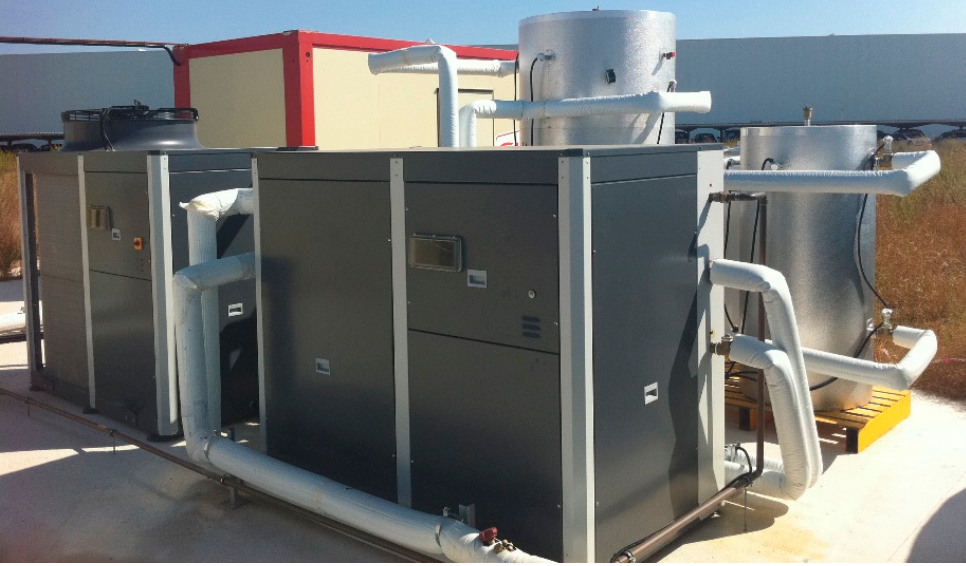
Figure 14. Small ‐ capacity, air ‐ cooled, single ‐ effect ammonia/LiNO 3 absorption chillers manufactured Figure 14. Small-capacity, air-cooled, single-e ff ect ammonia / LiNO 3 absorption chillers manufactured by CIATESA. Adapted from Reference [60]. by CIATESA. Adapted from Reference